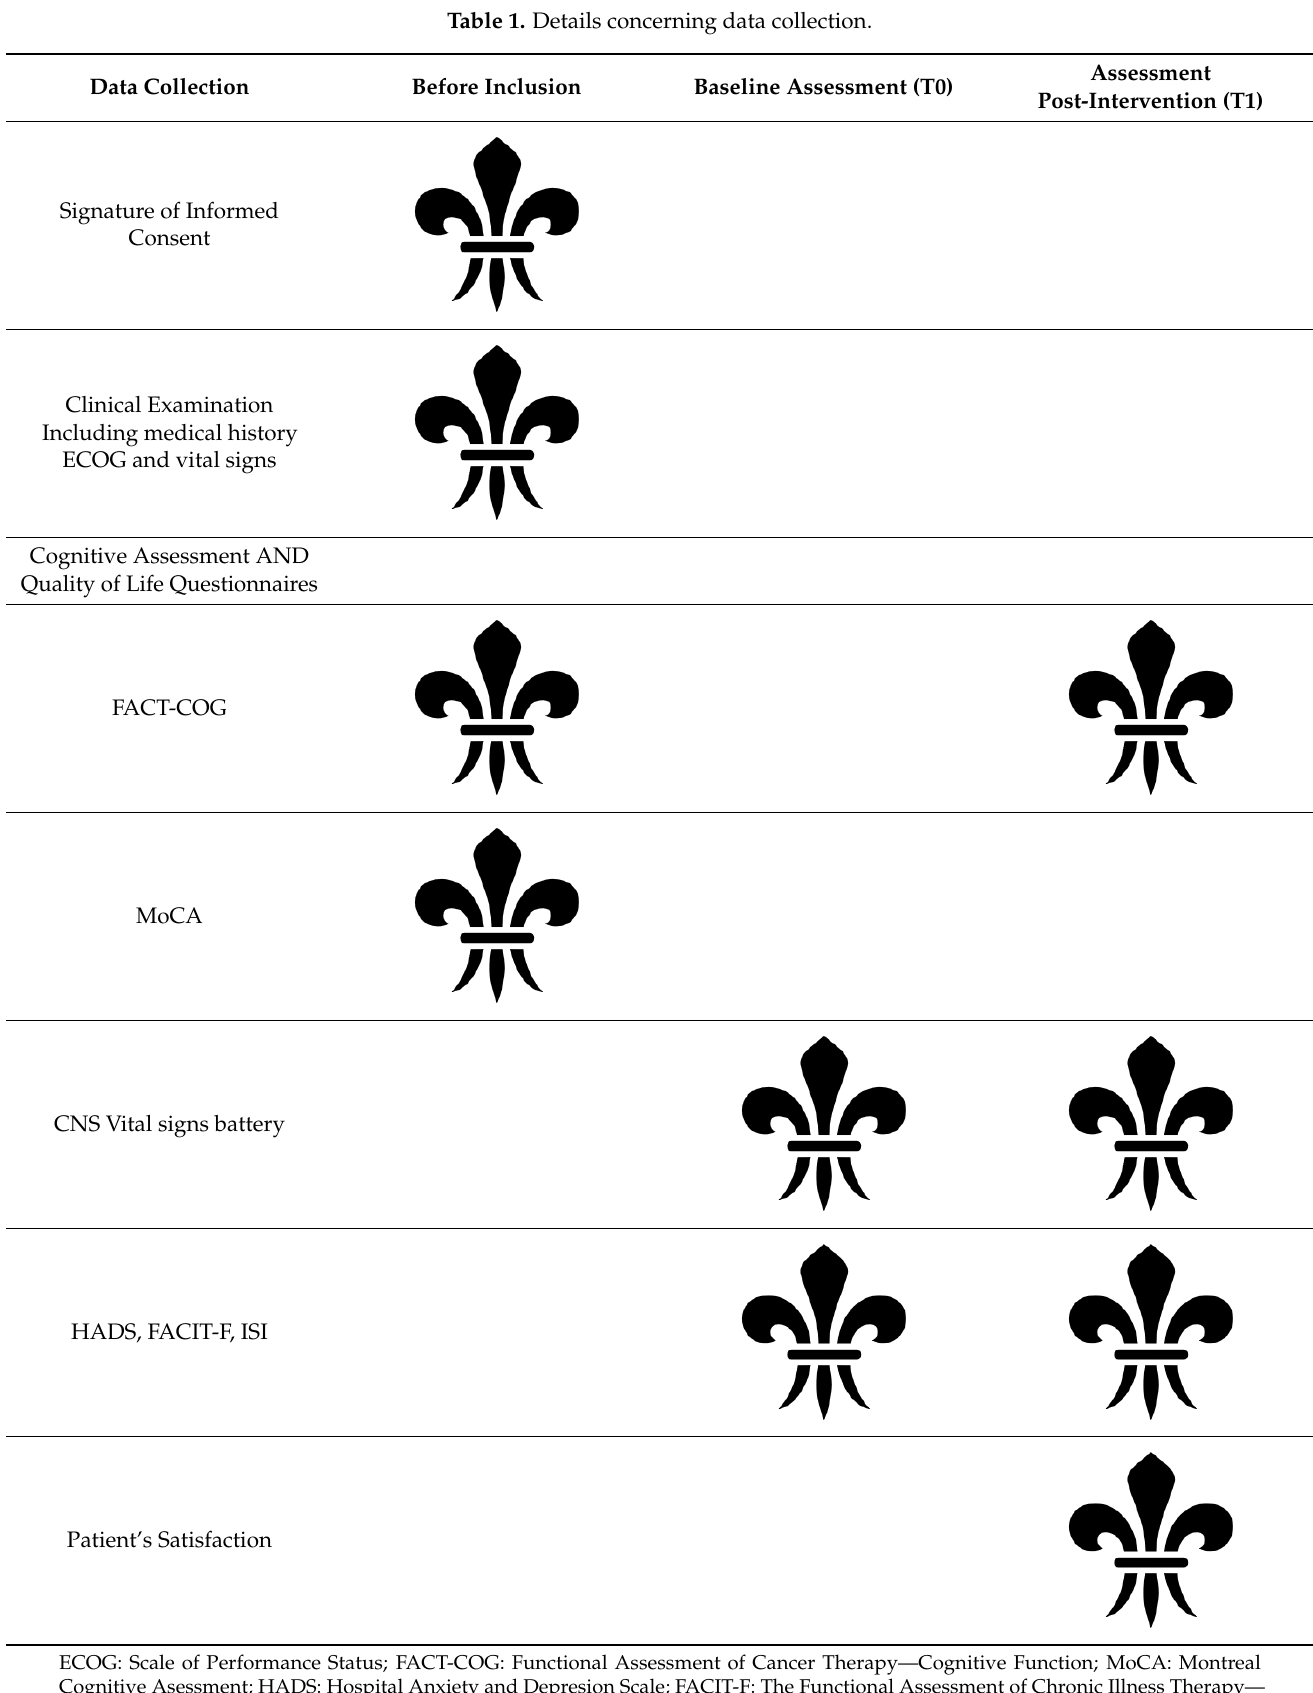
Table 1. Details concerning data collection.